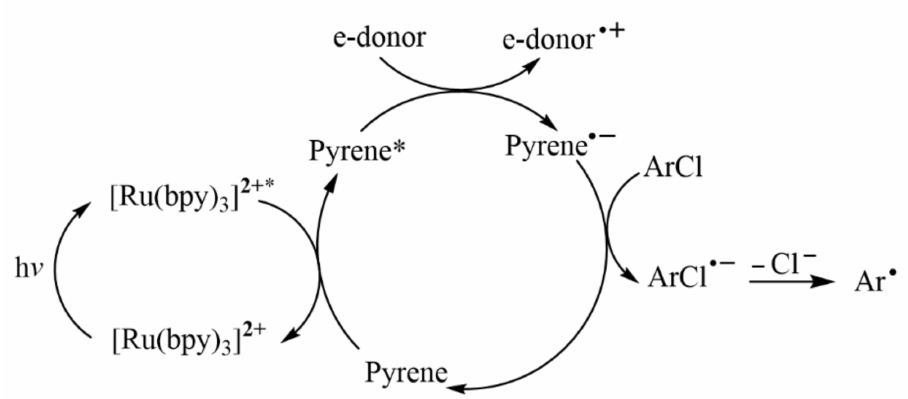
Figure 7. Proposed mechanism for two-center photo-redox catalysis with Ru(bpy) 3 Cl 2 /pyrene. Reprinted with permission from Ref. [35]. Copyright 2017, WILEY-VCH Verlag GmbH & Co. KGaA, Weinheim.